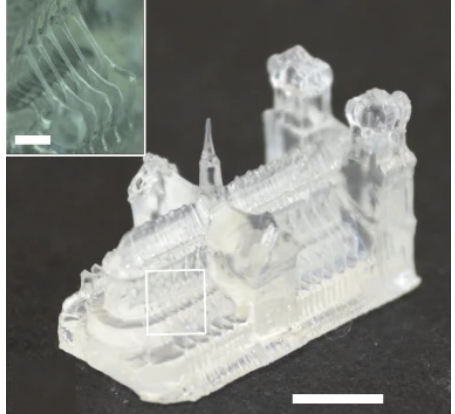
Figure 21. “Notre Dame” printed part using the novel tomographic multi-beam method. The scale bars are 5 mm in the main image, and 1 mm for the inset [122].